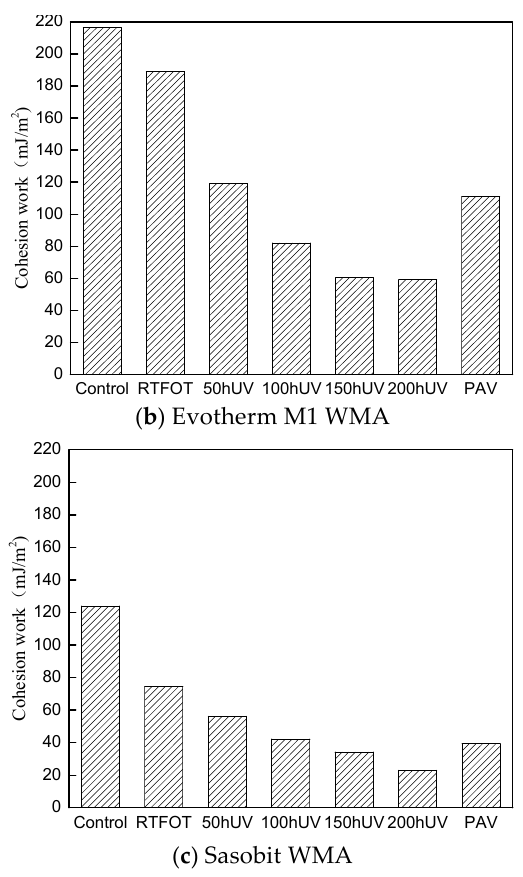
Figure 5. Influence of aging on cohesion work of aged asphalt.